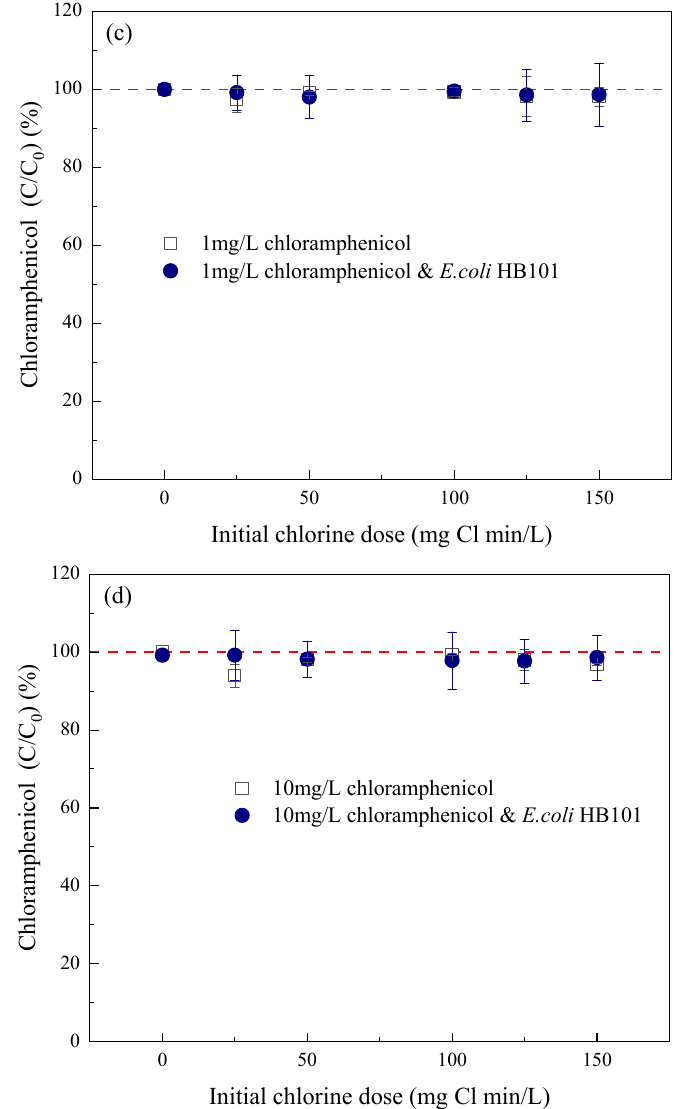
Figure 4. The removal effects on chloramphenicol and ARB of chlorine disinfection system. ( a ) The survival rate of E. coli HB101 under different concentrations of chloramphenicol. ( b ) Inactivation rate of chlorine disinfection system with or without chloramphenicol. ( c ) The removal effects on 1 mg/L chloramphenicol with the chlorine disinfection system with or without ARB. ( d ) The removal effects on 10 mg/L chloramphenicol with the chlorine disinfection system with or without ARB. The error lines represent the standard deviation of 3 replicate experiments; the ‘*’ indicates a significant difference between the experimental and control groups.